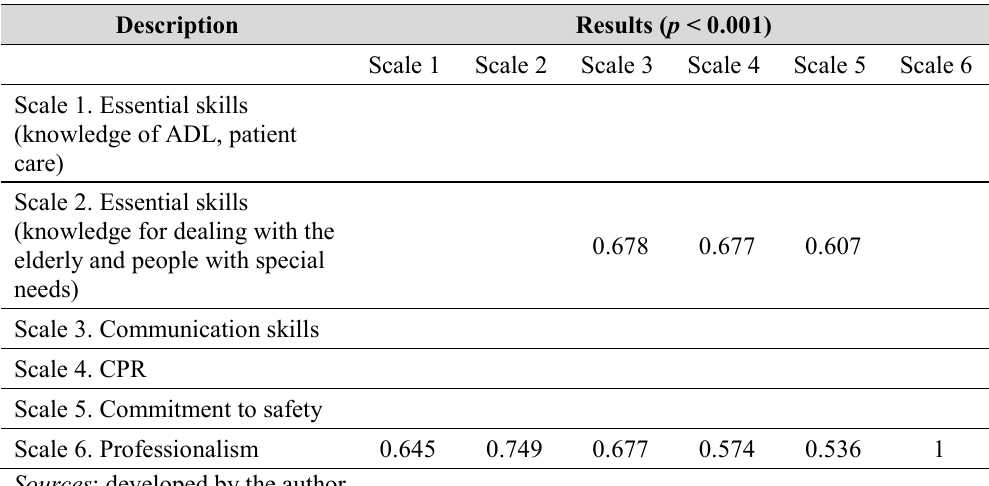
Table 1. Relations between